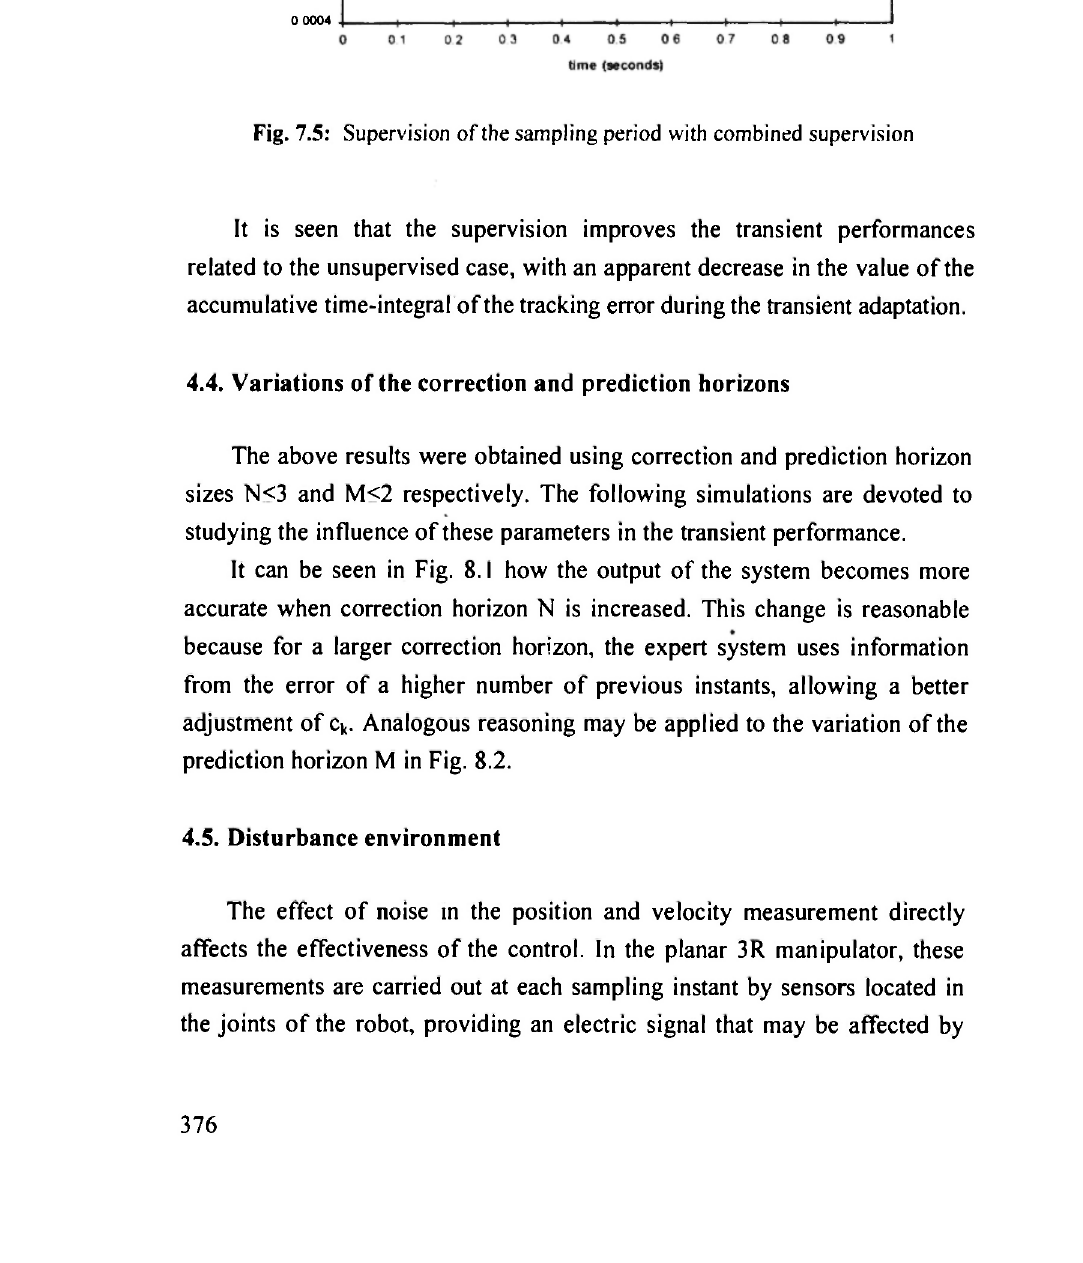
Fig. 7.5: Supervision of the sampling period with combined